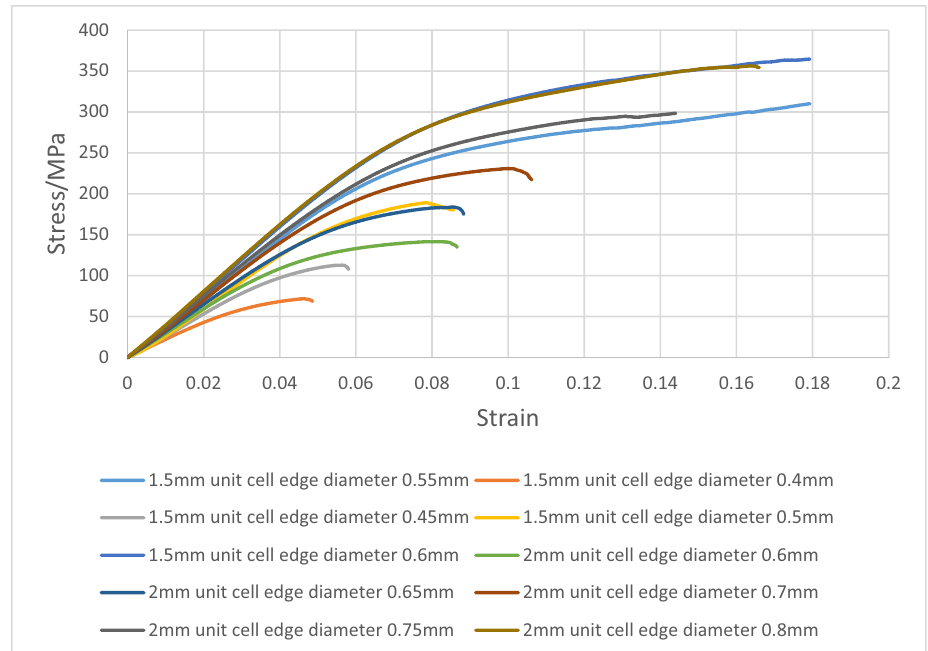
Figure 15: Stress – strain curves of ten specimen in compression